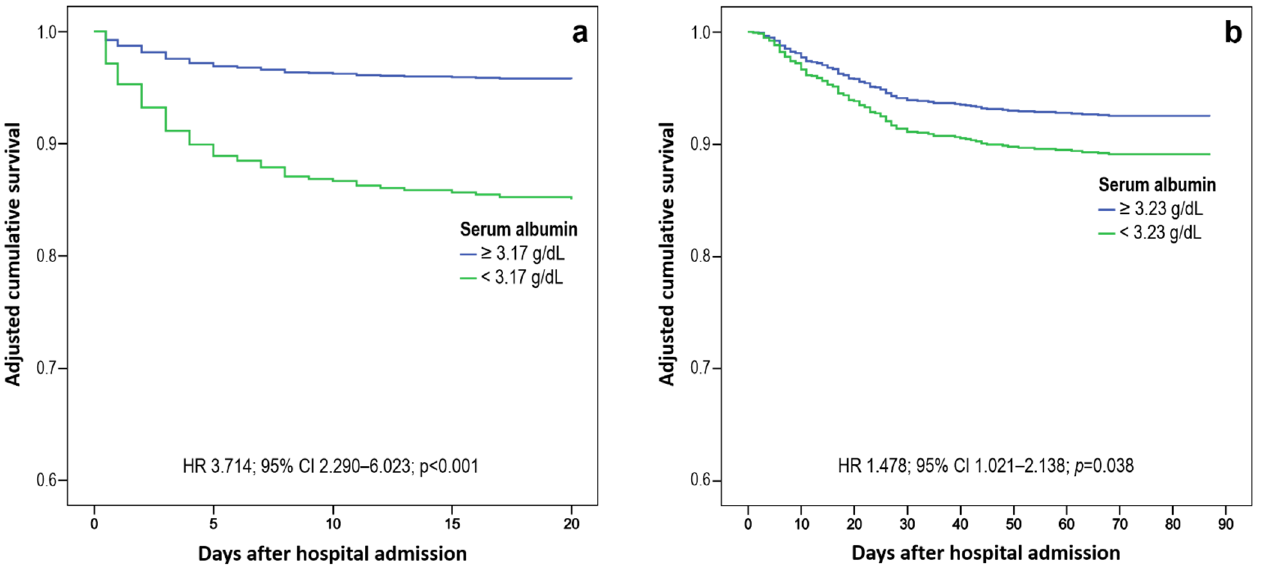
Figure 2. Adjusted Kaplan-Meier curves for risk to invasive mechanical ventilation ( a ) and 90-days mortality ( b ) according to the identified specific best risk thresholds of albumin at hospital admission. Table 2. Logistic regression analysis on independent predictor for PaO 2 /FiO 2 < 100.